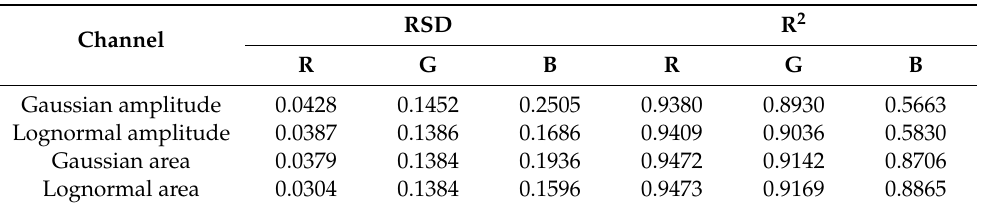
lognormal area with 5 as the number of accumulated pulses.